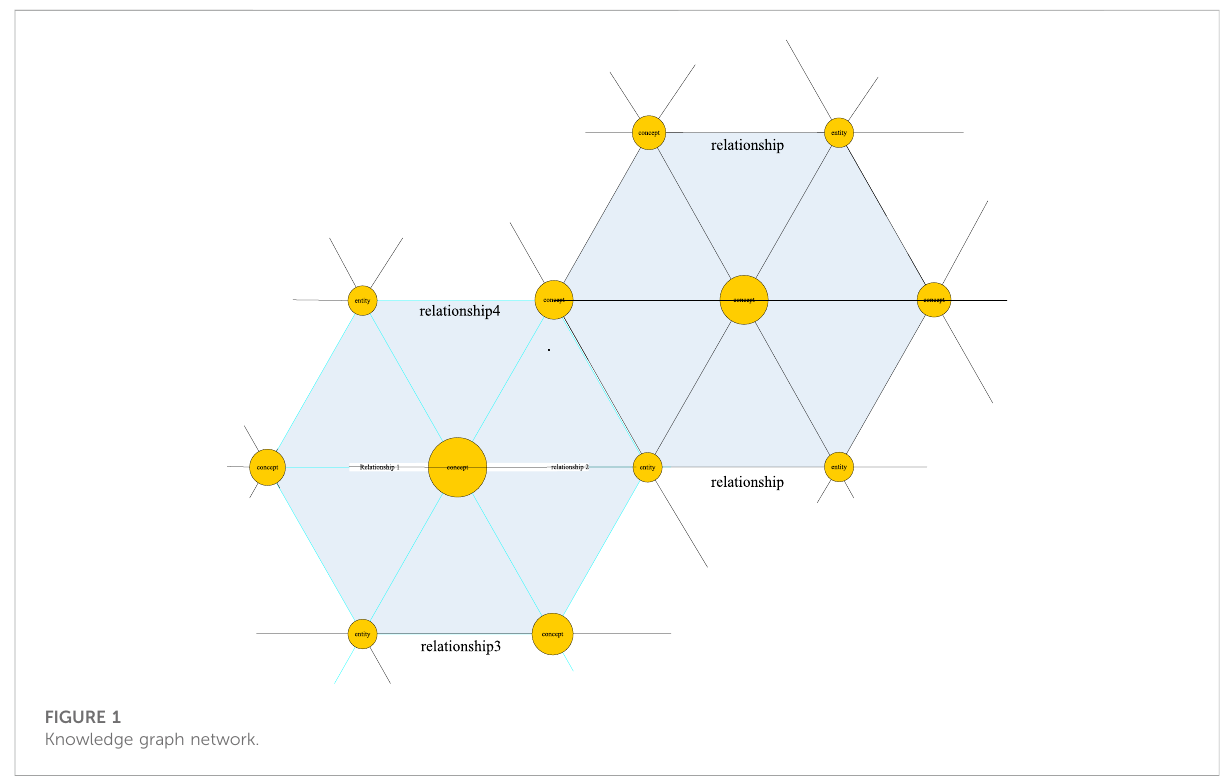
FIGURE 1 Knowledge graph